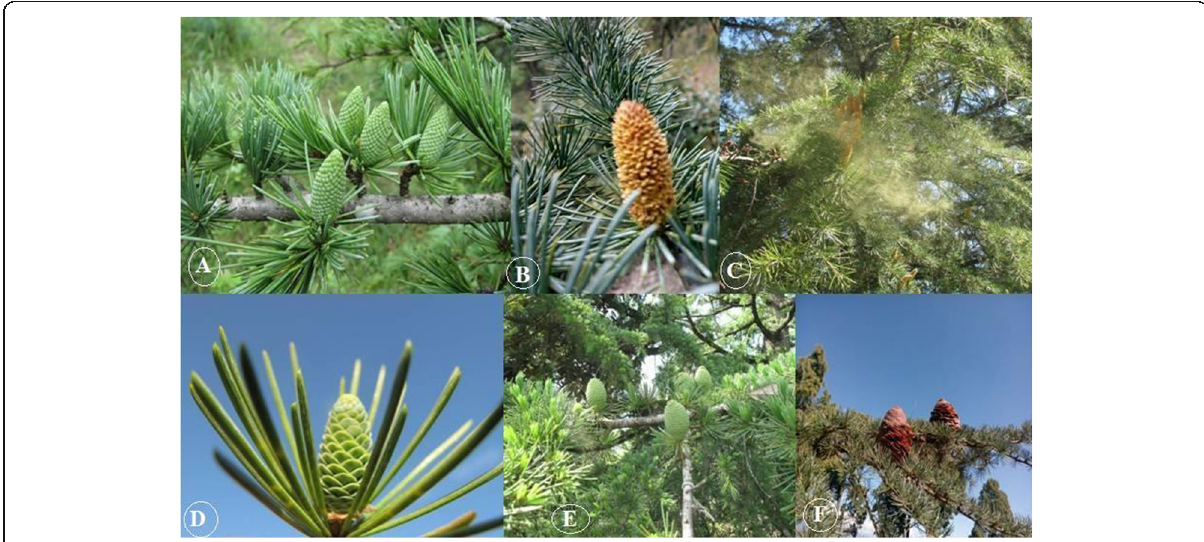
Fig. 3 Pre-fertilization phenological events in Cedrus deodara. a – b Male cone initiation and development ( a , June - b , October). c Explosive pollen release assisted by wind (October). d Initial stage of female cone (October) and e Development of female cone (Next season June) f Developed/ mature female cone